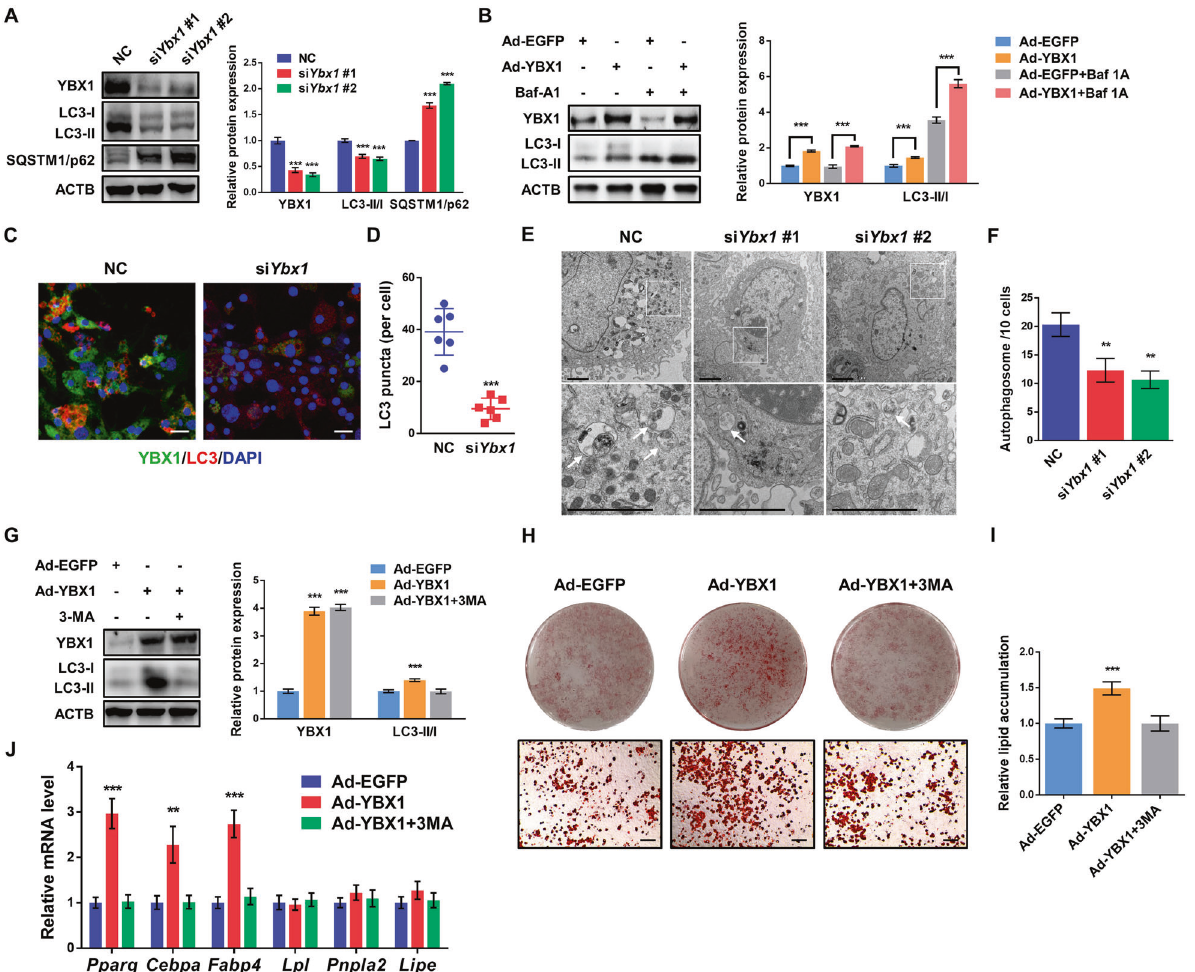
Fig. 2 YBX1 facilities adipocyte differentiation through promoting autophagy. A Western blot analysis of YBX1, LC3 and SQSTM1 in NC and YBX1 knockdown 3T3-L1 cells. B Western blot analysis of YBX1 and LC3 in cells infected with EGFP- or YBX1-expressing adenovirus and treated with or without 10 nM Baf A1 for 4 h. C Immuno fl uorescence detection of YBX1 and LC3 in NC and YBX1 knockdown cells. Scale bar: 20 μ m. D Statistical analysis of the number of LC3 puncta per cell. E Transmission electron microscope analysis of autophagosomes in NC and YBX1 knockdown cells. Arrows indicate autophagosomes. Scale bar: 2 μ m. F Quanti fi cation of autophagosomes in cells. G Western blot analysis of LC3 in cells infected with EGFP- or YBX1-expressing adenovirus and treated with or without 10 mM 3-MA for 4 h. H Oil Red O staining of cells infected with EGFP- or YBX1-expressing adenovirus and induced to differentiate in the presence or absence of 5 mM 3-MA for 6 days. Scale bar: 100 μ m. I Relative lipid accumulation was quanti fi ed with a microplate spectrophotometer at 500 nm. J qPCR analysis of Pparg , Fabp4 , Cebpa, Lpl, Pnpla2 and Lipe expression in cells infected with EGFP- or YBX1-expressing adenovirus and induced to differentiate in the presence or absence of 5 mM 3-MA for 6 days. The data were presented as the mean ± SD of triplicate tests. * P < 0.05, ** P < 0.01, *** P < 0.001 compared to control